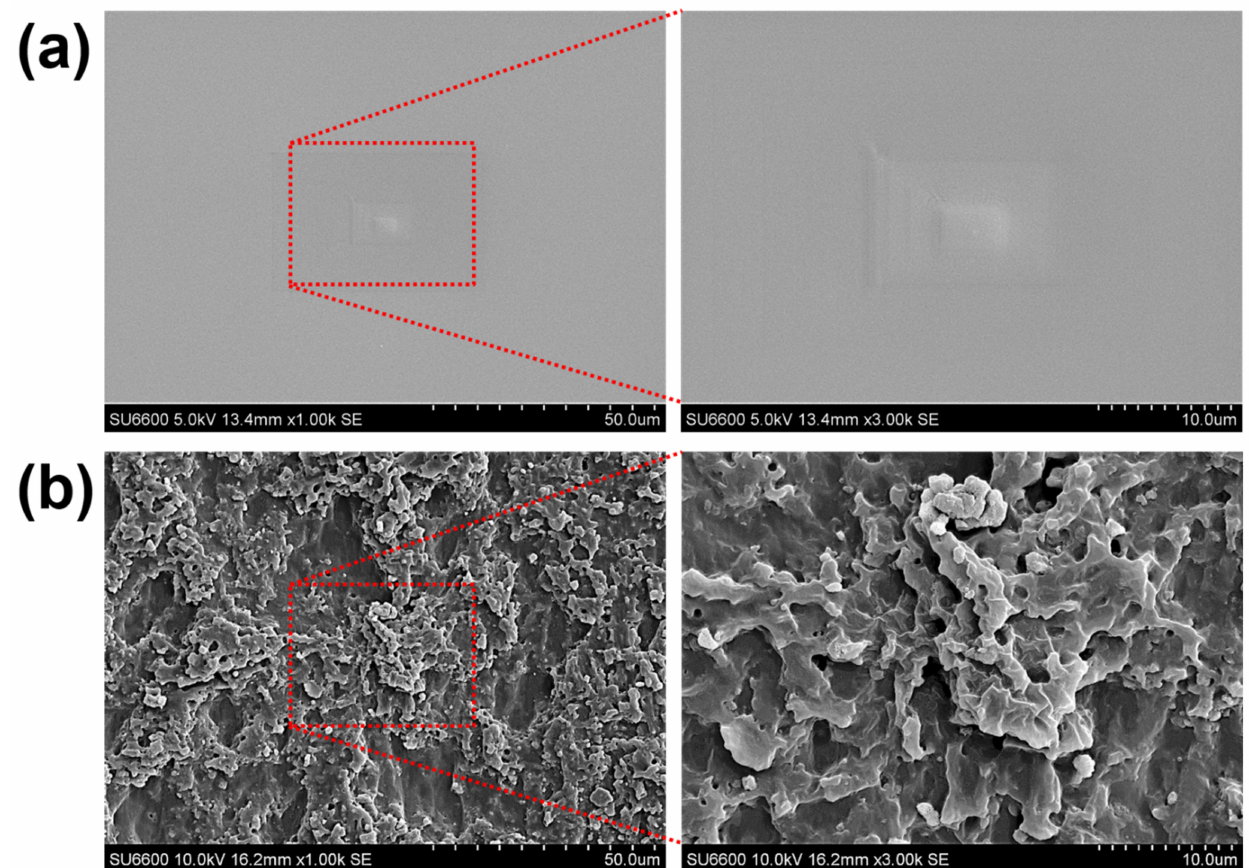
Figure 2. SEM images of surface morphologies of PDMS specimens imprinted on ( a ) flat Al plate and